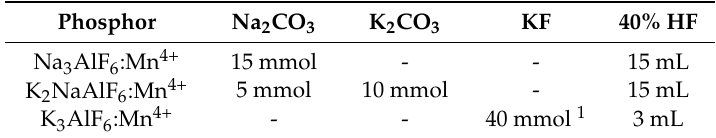
Table 1. Amounts of Na 2 CO 3 , K 2 CO 3 , KF and 40% HF (aq) used in the synthesis of M 3 AlF 6 :Mn 4+ (M = Na,